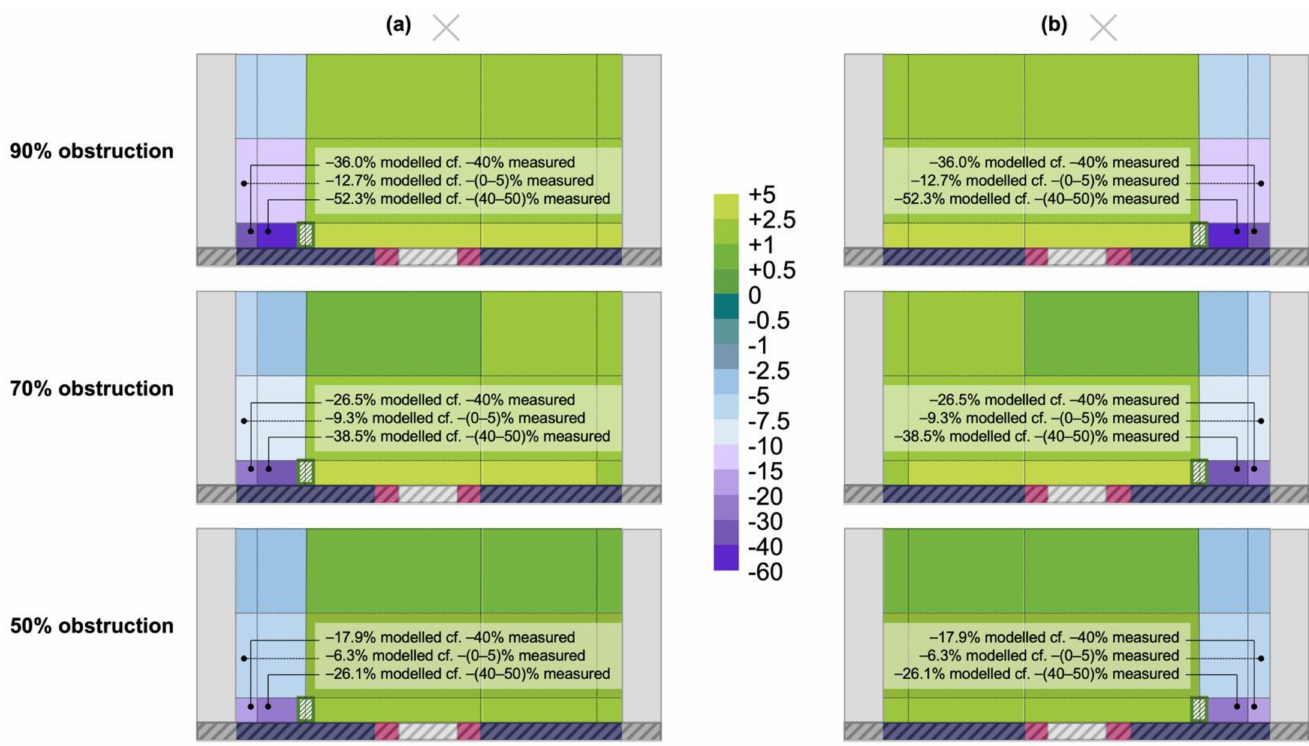
Figure 11. Modelled changes in SF 6 mass concentration (%), on introducing a roadside barrier in a street canyon under parallel wind conditions aloft, when the barrier is located ( a ) on the left of the street, and ( b ) on the right of the street, as we seek to emulate [49]’s wind tunnel